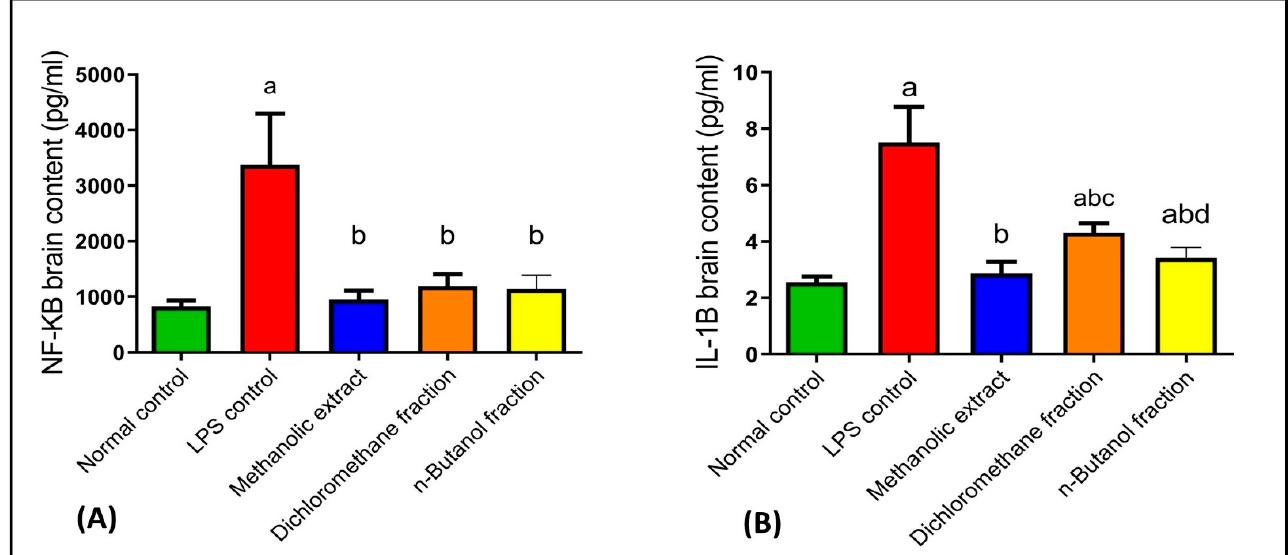
Figure 4. Effects of BME, BDMF, BBF on NF- κ B ( A ) and IL-1 β ( B ) in LPS-induced Alzheimer in mice. Data are presented as the mean ± standard error (SE) of n = 8 per each group. Statistical